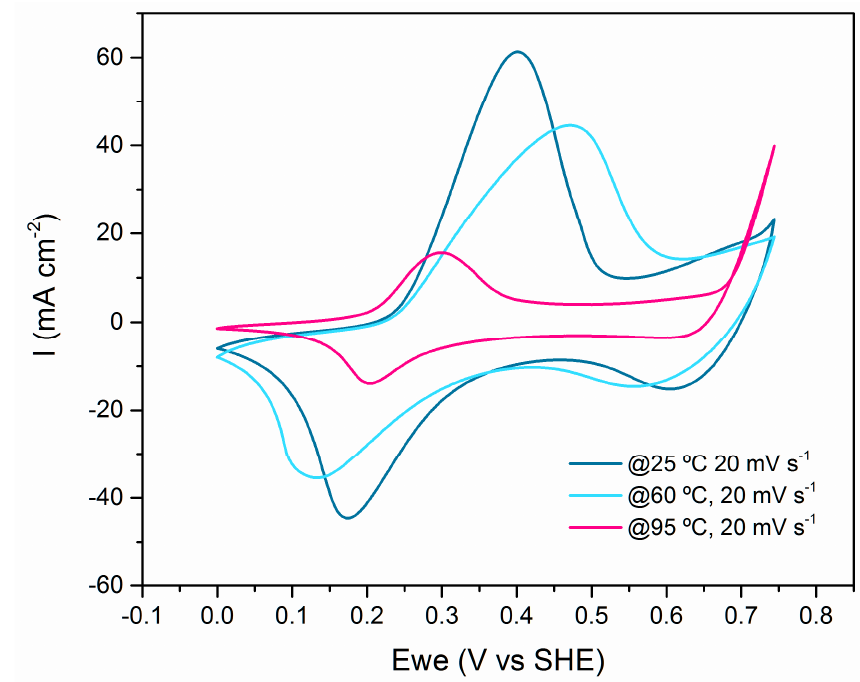
Figure 7. Cyclic voltammograms of Co(OH) 2 from 0 to 0.7 V vs. Standard Hydrogen Electrode (SHE) at a scan rate of 20 mV s − 1 in 1 M KOH.